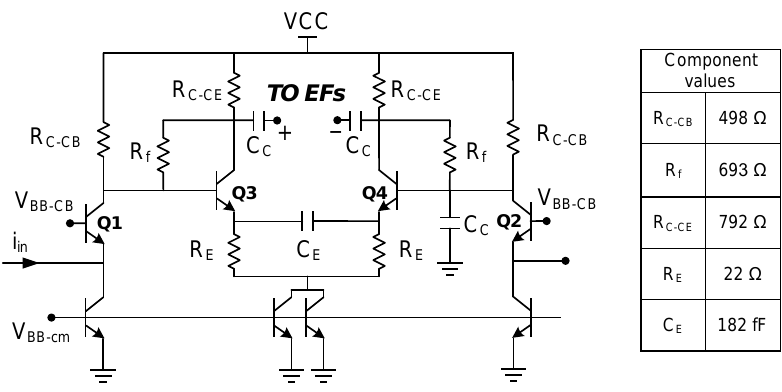
Figure 4. Schematic of the TIA stage